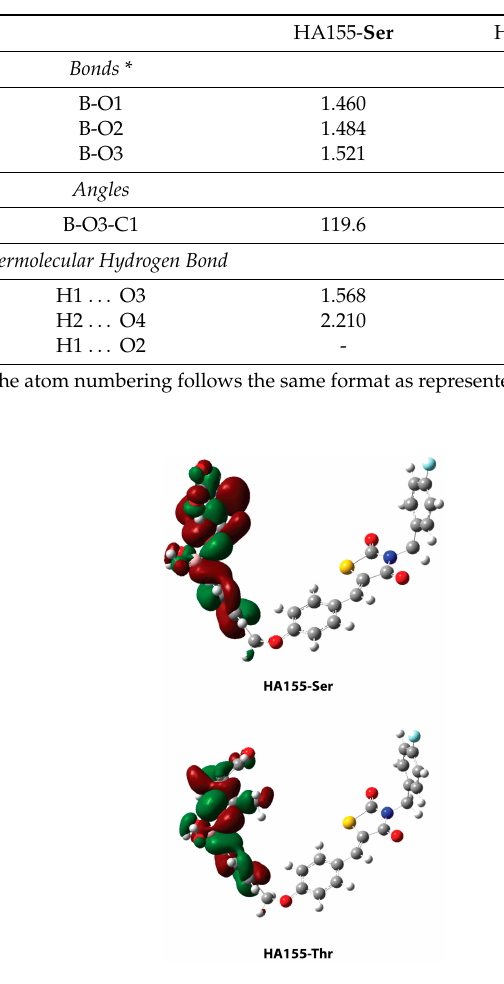
Figure 5. Optimized geometries of the bonded structures of the inhibitor HA155 with serine ( top ) and threonine ( bottom ) at the B3LYP/6-31+G(d,p) level of theory, with their respective intramolecular HBs as dashed lines. Table 2. Geometrical parameters of the HA155- Ser and HA155- Thr . The bonds are given in Å and the angles in degrees.